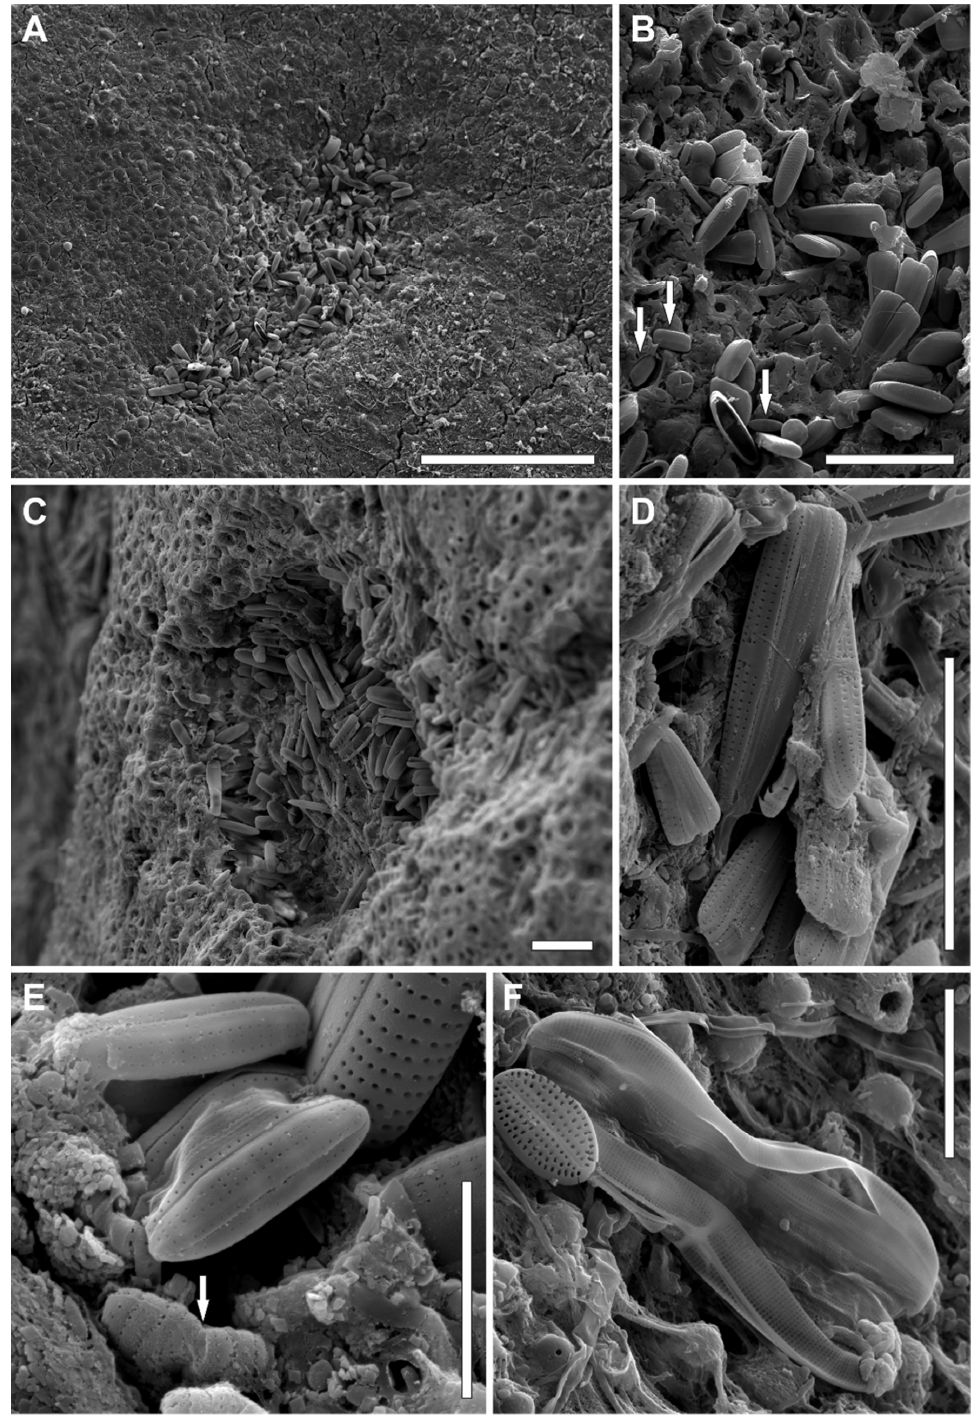
Figure 4. SEM micrographs showing diatom assemblages on South African kelps. ( A – E ) Diatoms colonising cavities in the surface layer. ( B ) Rhoicosphenia genuflexa , Gomphoseptatum pseudoseptatum , and Nagumoea sp. (arrows). ( C ) Assemblage dominated by Navicula spp. ( D ) Gomphoseptatum pseudoseptatum. ( E ) Nagumoea sp. and apical part of a cell of Gomphoseptatum pseudoseptatum (arrow) immersed in the kelp tissue. ( F ) Craspedostauros australis . Scale bars: A = 100 µm; B–D = 20 µm; E = 5 µm; F = 10 µm.